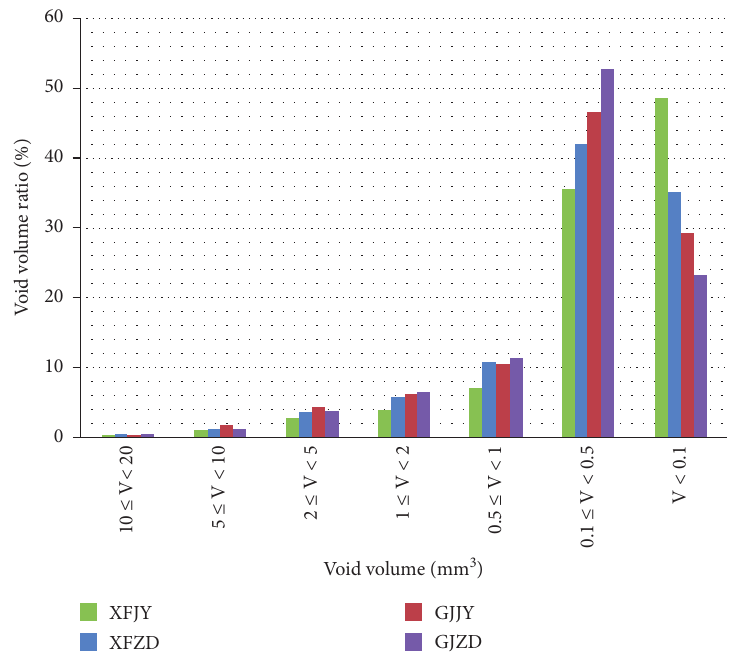
Figure 8: Void gradation distribution of CSM.